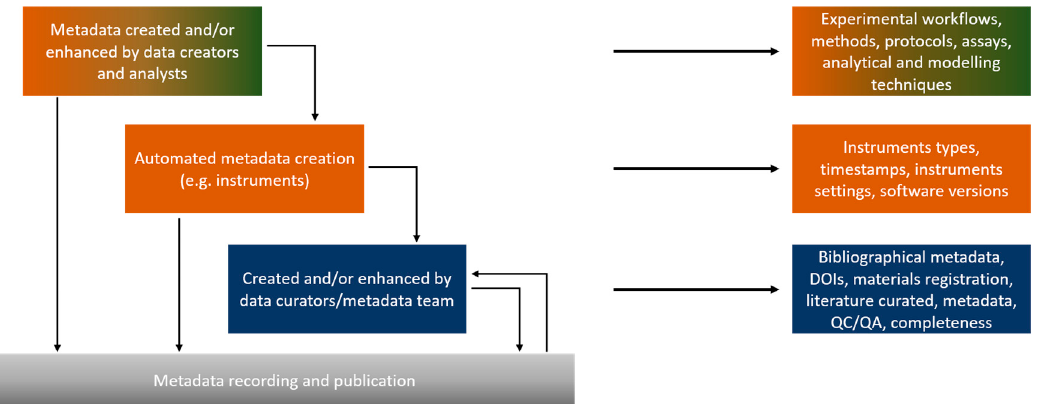
Figure 4. The metadata capture workflow and the respective metadata. Note that the colours in the metadata boxes correspond to the stages of the data life cycle in Figure 2, with orange representing descriptive metadata associated with the planning and acquisition stages, green representing technical metadata from the processing and analysis stages, and navy blue representing bibliographic metadata from the storing and sharing stages.